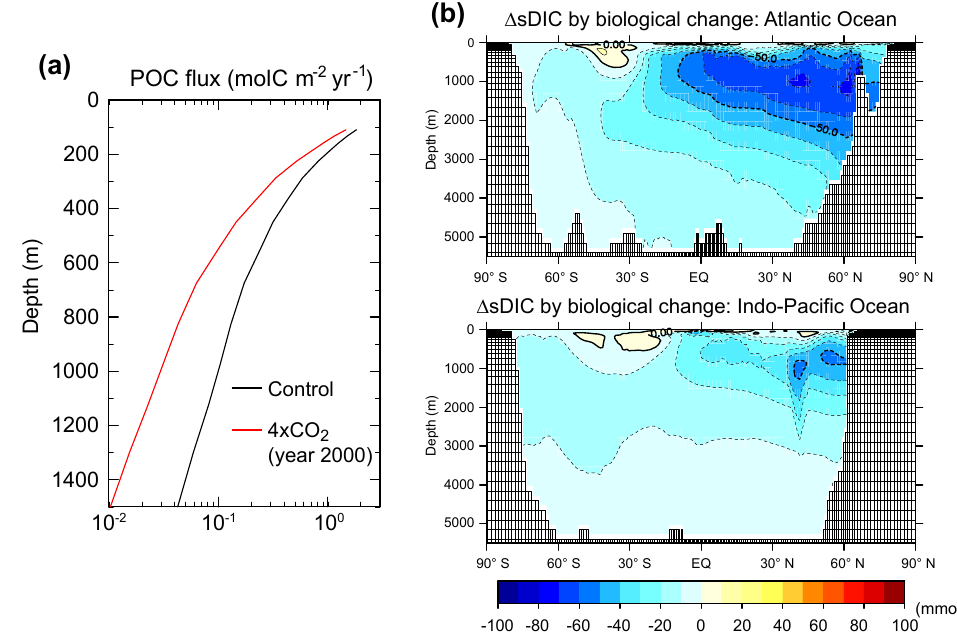
Figure 9. Contribution of the reorganization of the organic matter cycle. (a) Vertical distribution of the POC flux for the control (black) and global warming runs (red). (b) Zonal mean changes in the salinity-normalized DIC induced by changes in the organic matter cycle in the CTL-base and GW-base experiments at 500 years. The top and bottom panels show the Atlantic and Indo-Pacific oceans,